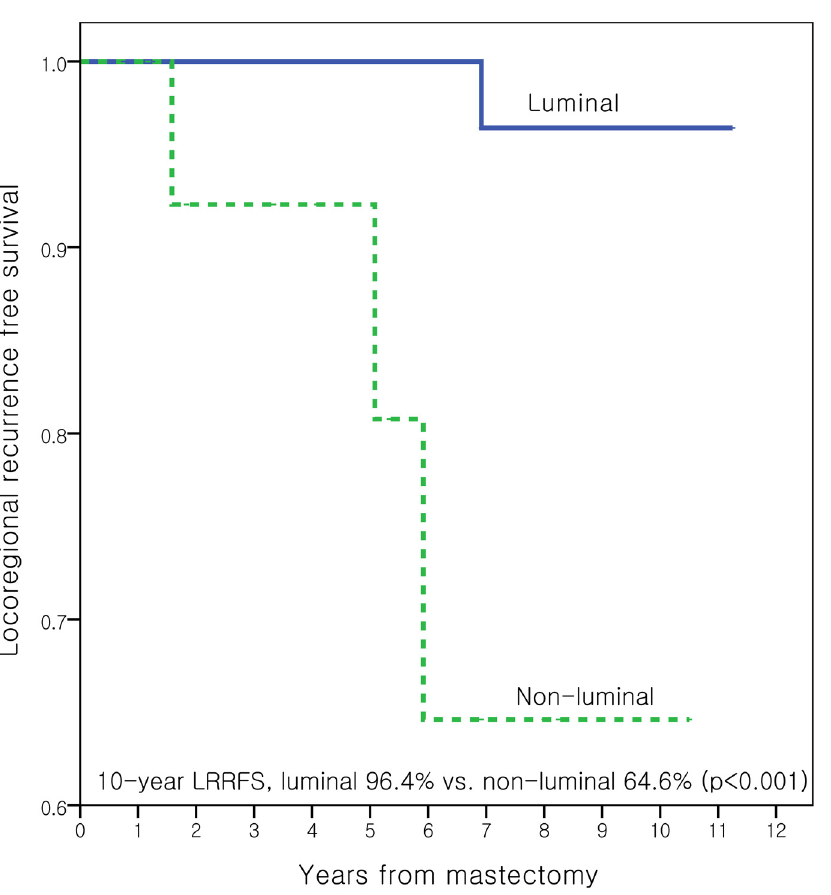
Fig 3. Kaplan-Meier curves for locoregional recurrence free survival (LRRFS) according to the luminal subtype in pN1